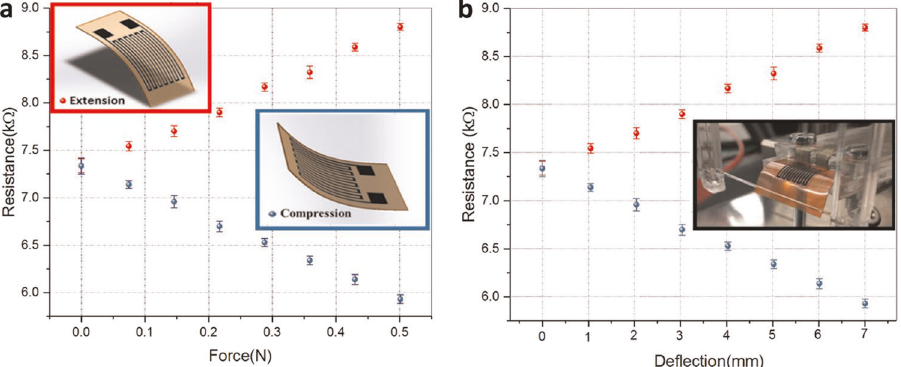
Fig. 3 Average resistance as a function of a force and b de fl ection induced during extension and compression of LIG. The error bars indicate the standard deviation. The coef fi cient of determination ( R 2 ) is 0.9961 during extension and 0.9984 during compression